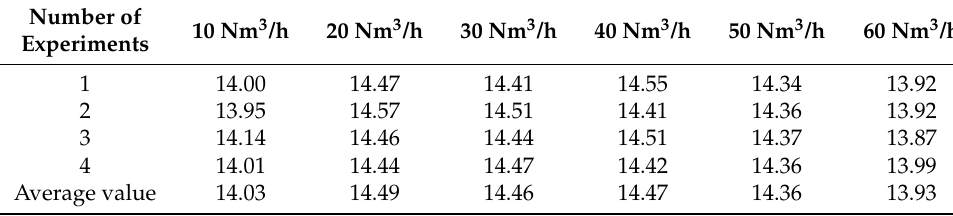
Table 5. Liquid particle size in Case 1 at M 2 ( µ m).